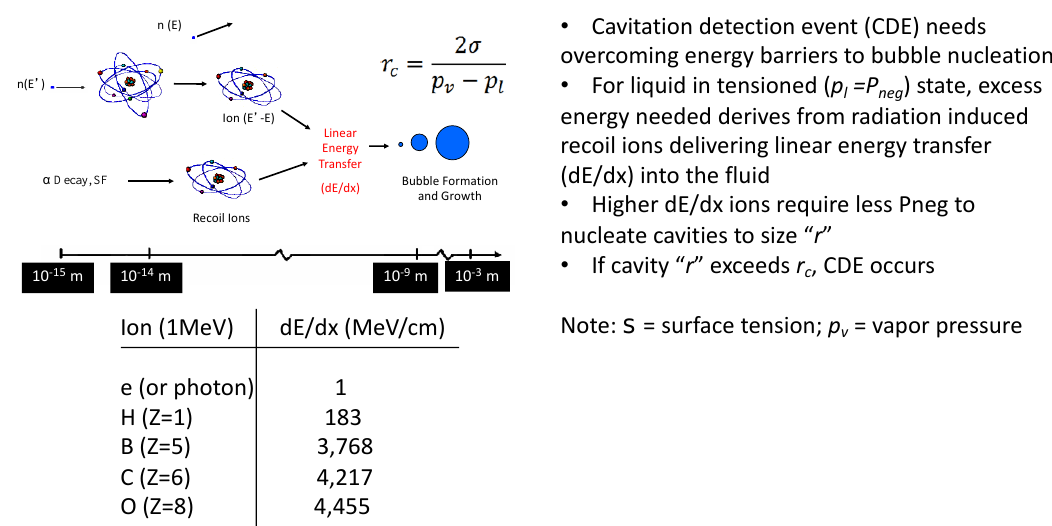
Figure 4. Graphical illustration summarizing key principles in TMFD sensor detection.